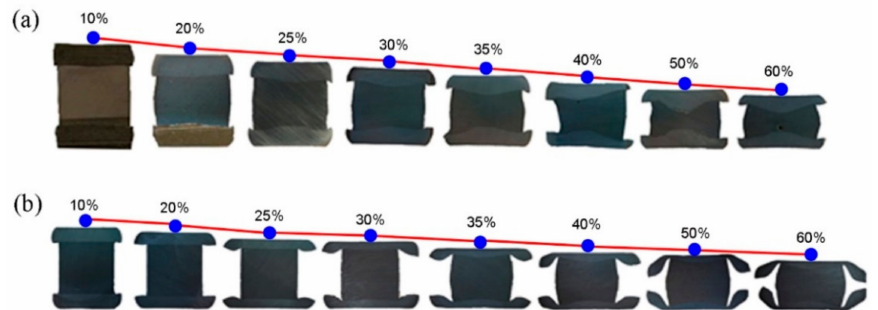
Figure 1. Macro-images of the sandwich samples of Ti-46Al-8Nb alloy after the hot compression process with the di ff erent packaging materials and deformation degrees: ( a ) stainless steel, ( b ) TC4 titanium